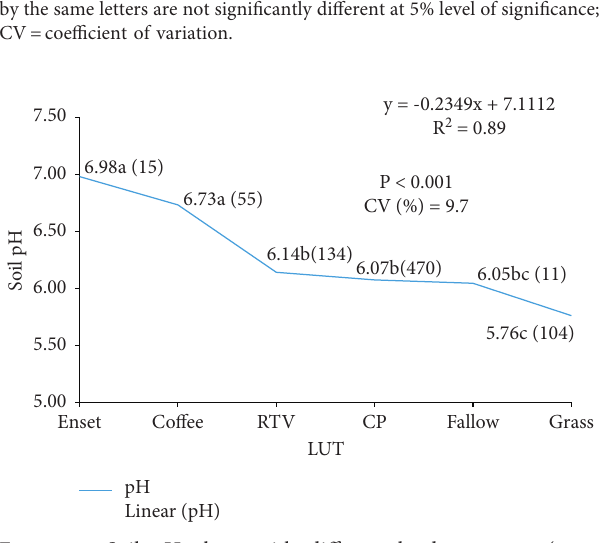
Figure 5: Soil pH along with different land-use types (note: numbers in the bracket refer to sample size). RTV � root, tuber, and vegetable crop field; CP � crop field.